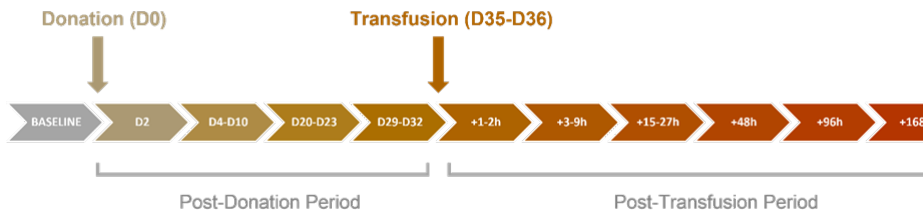
Figure 9. Schema of study design and sample collection (h = hours, D = day).